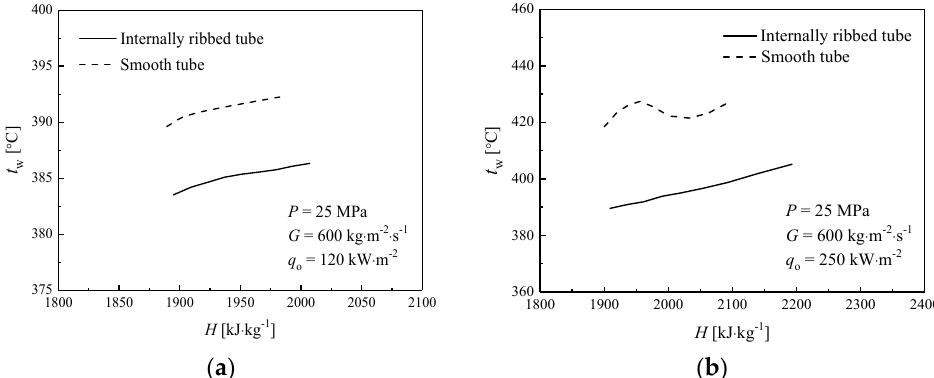
Figure 6. The inner-wall temperature in pseudocritical region. ( a ) Heat transfer enhancement; ( b ) Heat transfer deterioration. As shown in Figure 6a, at a low heat flux (i.e., q 0 = 120 kW · m − 2 ), the averaged inner- wall temperature of ST and IRT increases with the fluid bulk enthalpy, but the inner-wall temperature of IRT seem evidently lower than that in ST by 6~7 ◦ C. When the heat flux increased to a higher value (i.e., q 0 = 250 kW · m − 2 ), as shown in Figure 6b, the corresponding